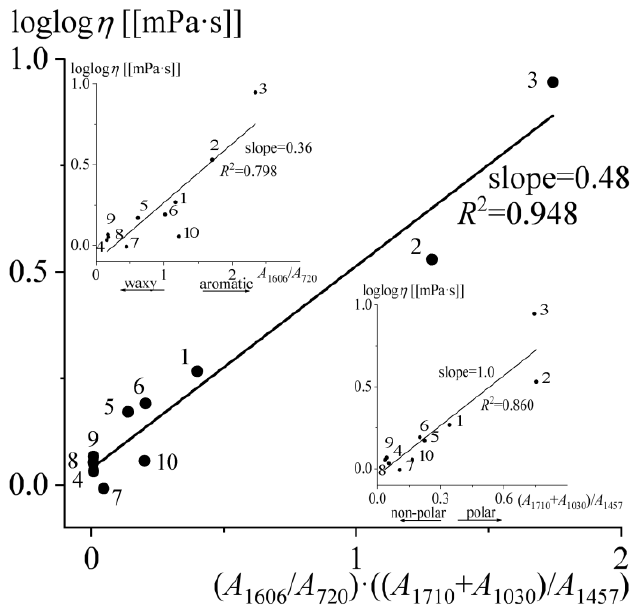
Figure 8. Dependence of the double logarithm of bitumens’ viscosity at 135 ◦ C on the product of aromaticity and polarity. The insets show the same data depending on the aromaticity or polarity of the bitumens.